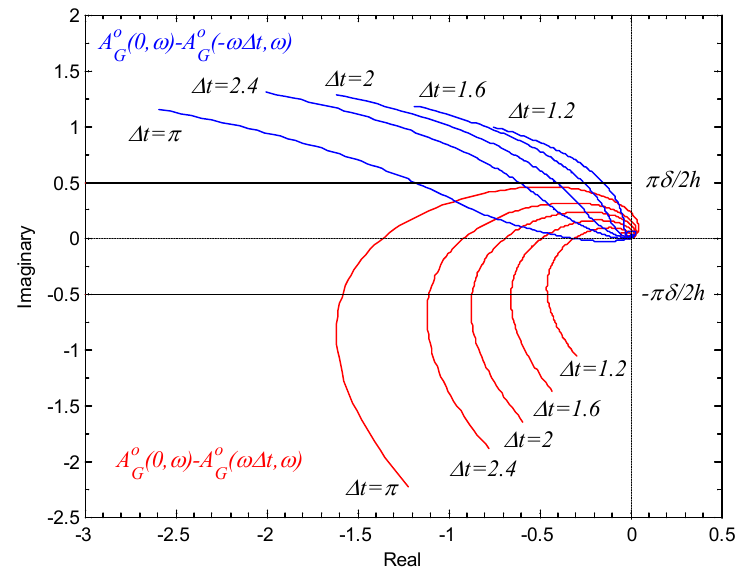
Figure 26. A loci for graphical solution for K = 1.